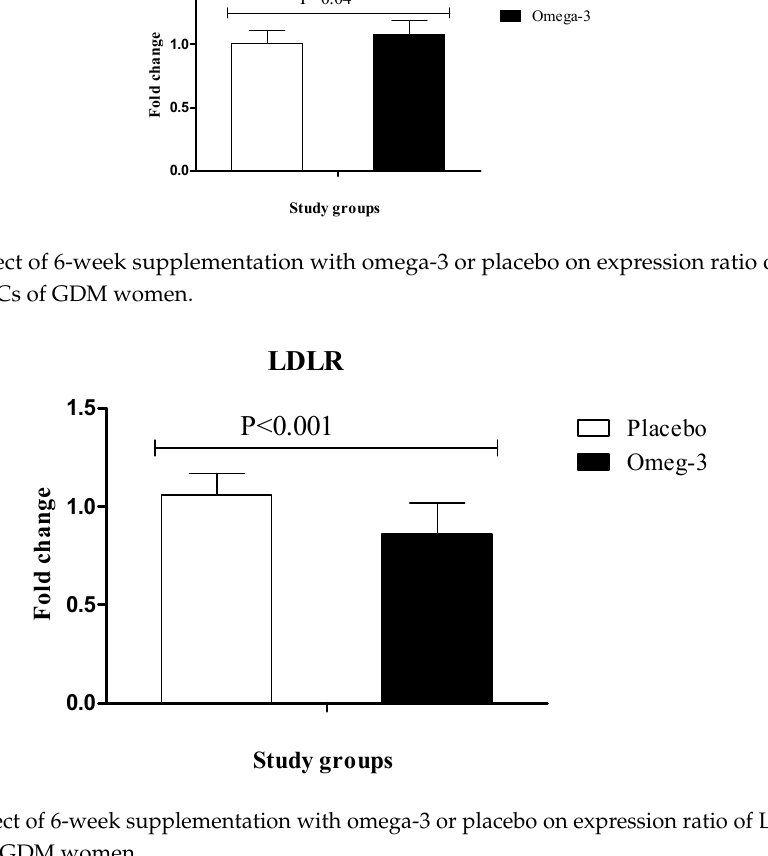
Figure 3. Effect of 6-week supplementation with omega-3 or placebo on expression ratio of LDLR gene in PBMCs of GDM women.